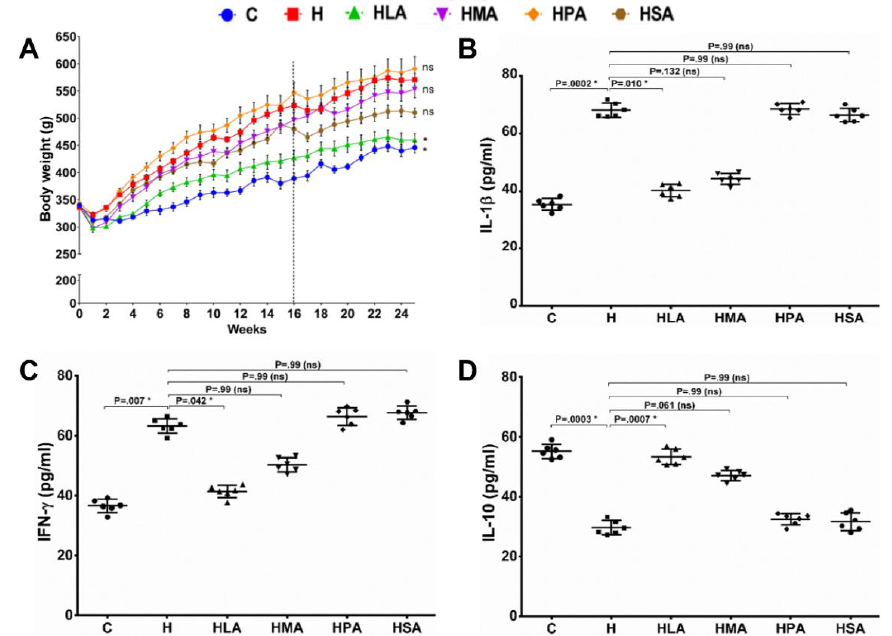
Figure 1. Weight gain and inflammatory markers in rat plasma. ( A ) Body weight of rats fed with the di ff erent saturated fatty acid diets for a period of 25 weeks (Dotted line showing the week of surgery); n = 6. * indicate p < 0.05 H vs. C, HLA, HMA, HPA and HPA. Plasma pro-inflammatory cytokine IL-1 β ( B ), IFN- γ ( C ) and anti-inflammatory cytokine IL-10 ( D ) concentrations in di ff erent saturated fatty acids diet-fed rats. All values are represented as mean ± SD, n = 6; p < 0.05. C, corn starch diet-fed rats; H, high-carbohydrate high-fat diet-fed rats; HLA, high-carbohydrate high-lauric acid diet-fed